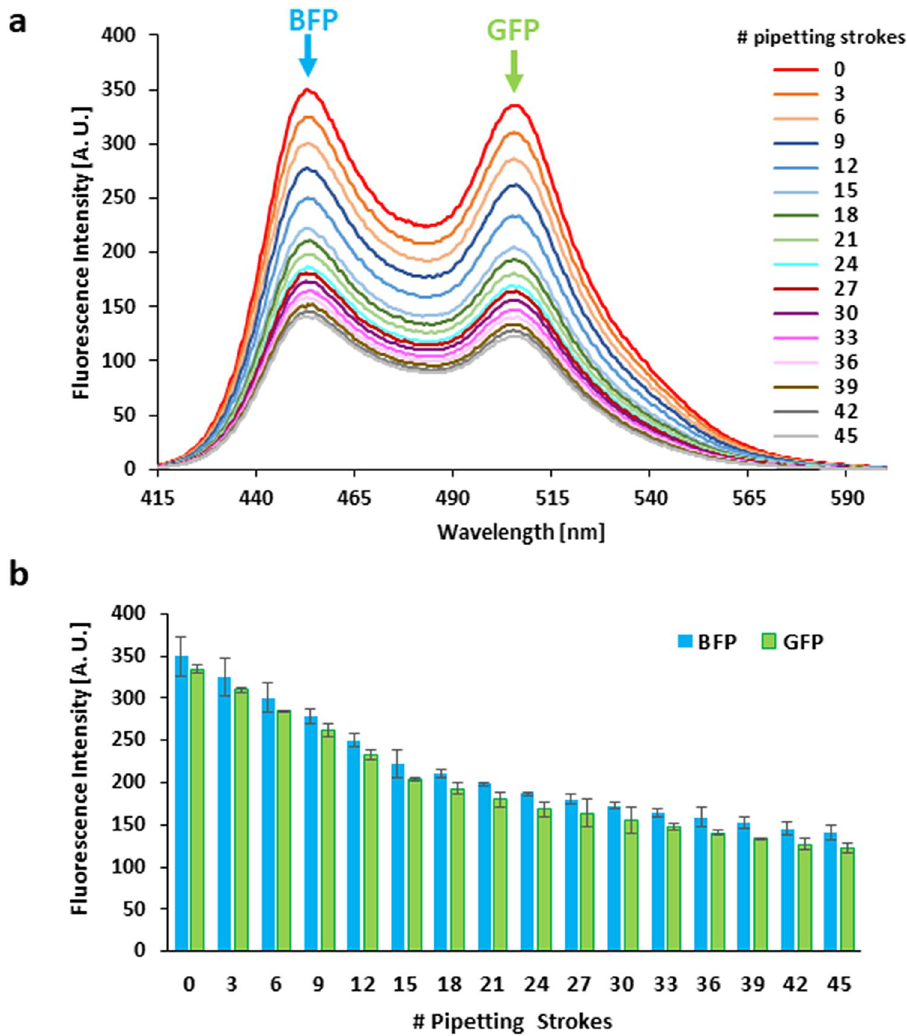
Figure 1. Effect of the number of pipetting strokes on the FUS fluorescence spectrum. ( a ) Overlaid fluorescence spectra of 100 nM FUS fusion protein (MBP-BFP-FUS-GFP-6xHis). The spectra were measured every 60 s, during which the sample (150 μL) was mixed by three strokes of pipetting (pipetting volume 140 μL). The total number of pipetting strokes is indicated on the right. ( b ) Bar graph showing the BFP (at 453 nm) and GFP (at 506 nm) fluorescence intensities of the fluorescence spectra shown in ( a ). The averages of two independent experiments ± standard deviation (SD) are